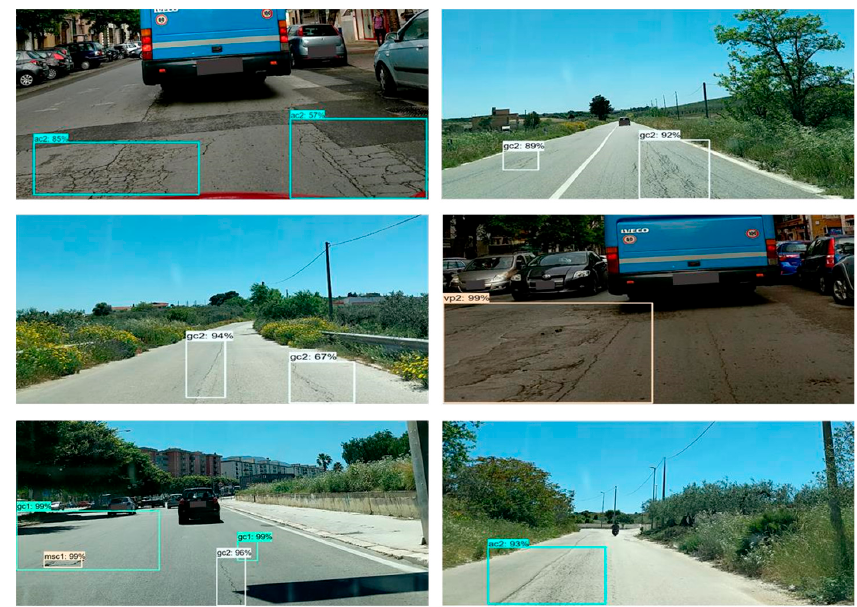
Figure 15. SSD with mobilenetv2 model predictions on test data.